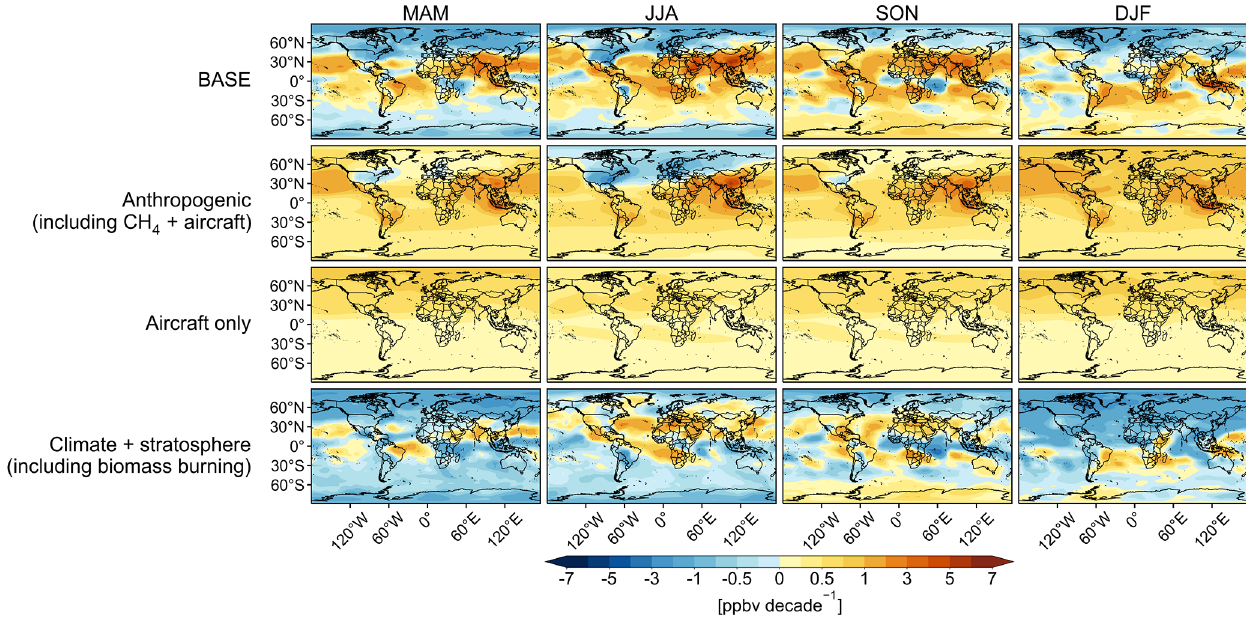
Figure 11. Drivers of seasonal mean tropospheric ozone (950–250hPa) trends from 1995 to 2017 estimated in GEOS-Chem model. Trends contributed by changes in anthropogenic emissions (surface emissions, aircraft emissions, and methane), aircraft emissions alone, and cli- matic and stratospheric factors are